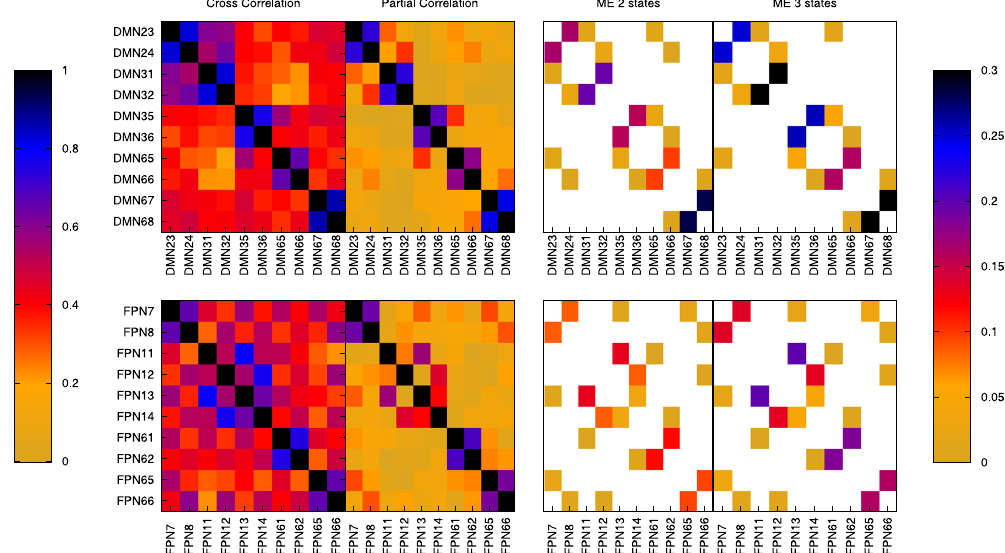
Figure 6. Internal structure of two resting-state brain networks — default mode network (top row) and the fronto-parietal network (bottom row) — represented by their weighted coupling matrix, which has been estimated by different methodologies. The different regions or nodes are labeled with network abbreviation and number according to the AAL brain atlas in ref. 41 The results based on a direct analysis of the original data using cross-correlations as well as partial correlations are shown on the left (note that absolute values are shown), while the results using our maximum entropy approach conditioned on all entropies and mutual informations for the discretized cases of 2 states and 3 states, respectively, are shown on the right. White entries indicate a conditional mutual information of exactly